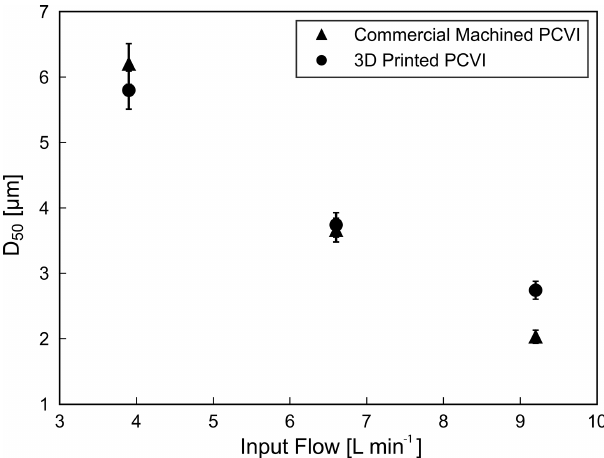
Figure 7. Comparison of D50 values for a commercial-machined and 3D-printed PCVI as a function of